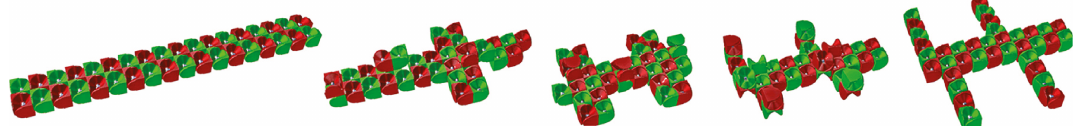
Figure 9: Environmental response mechanism.